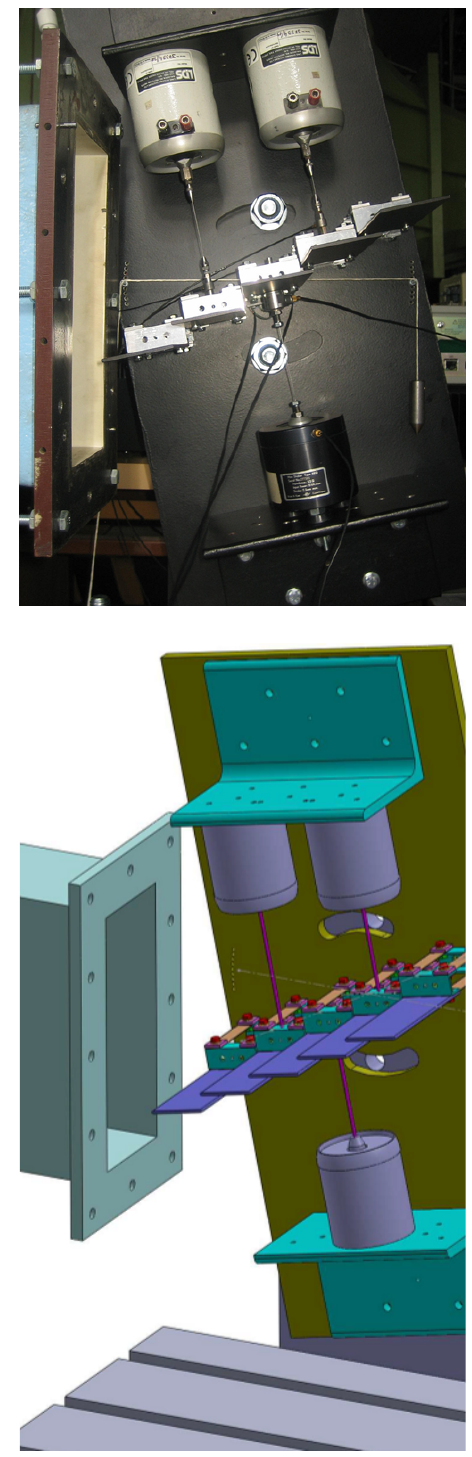
Fig. 2. Experimental stand of the simplified blade cascade (top) and its model created with CAD software